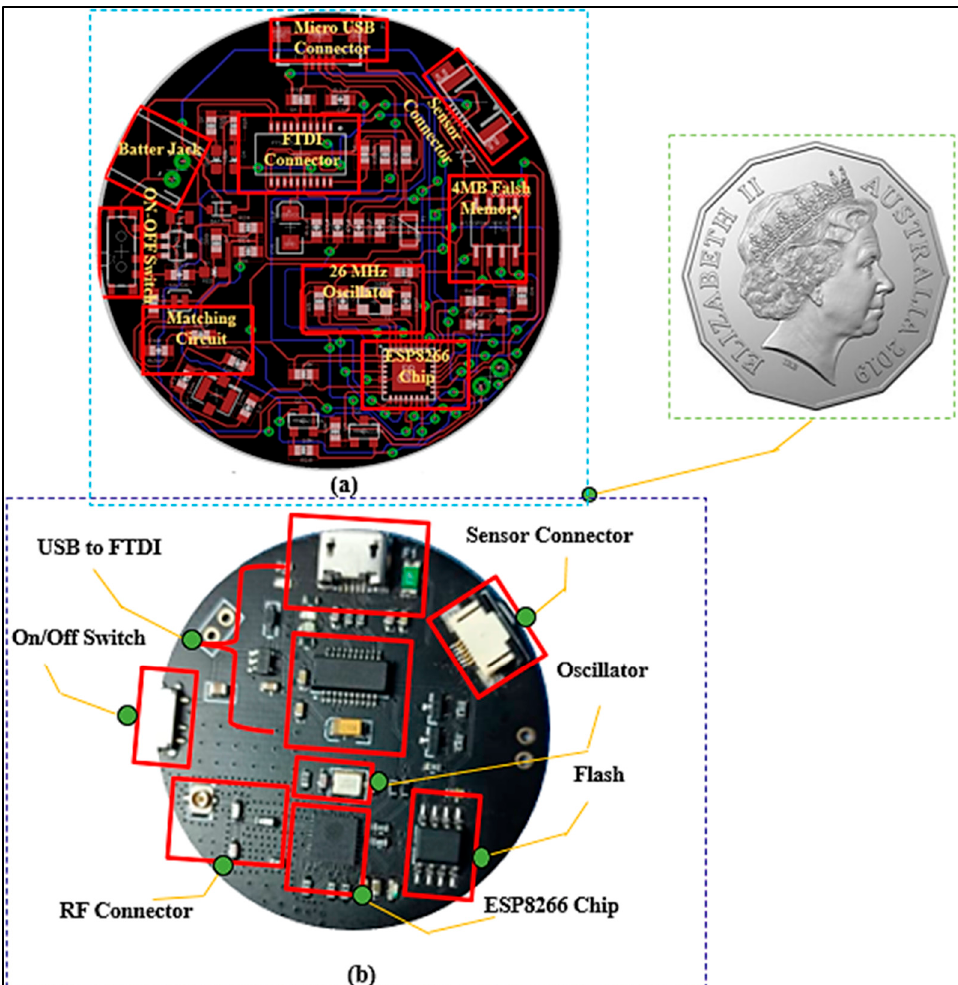
Figure 4. PCB Design. ( a ) PCB layout, and ( b ) fabricated prototype.